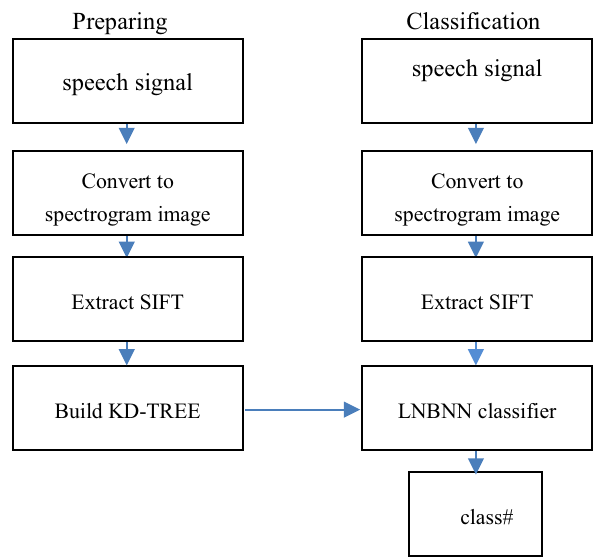
Fig. 6 Speech classification using LNBNN with SIFT